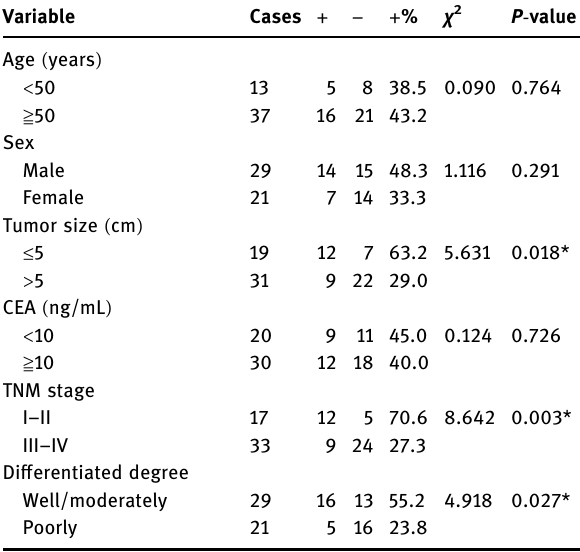
Table 4: Association between DNM3 expression and clinicopatho - logical parameters in CRC ( detected by immunohistochemistry )